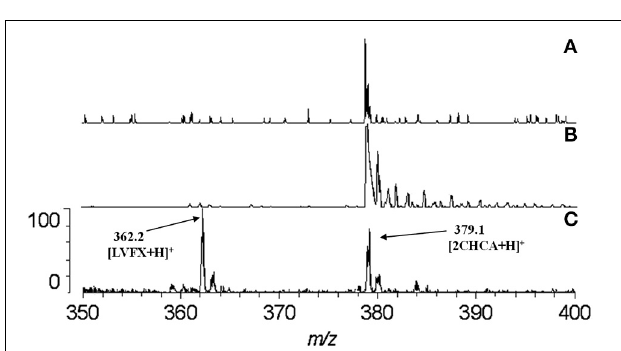
acylated conjugate species were observed. The baseline isotopic distribution for P4LC is shown in the inset with labeling of the monoisotopic peak.